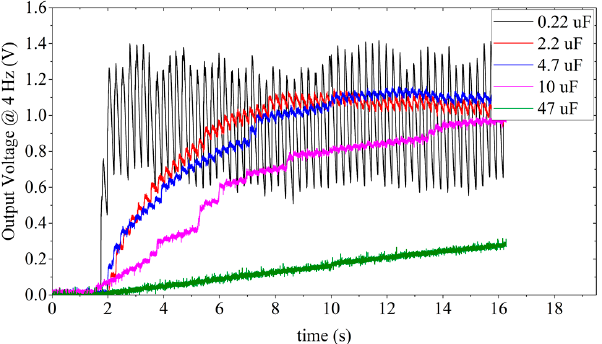
Figure 11. Charging different capacitors (0.22–47 µF) by WearETE under hand clapping movements with 4 Hz frequency. Sensors 2017 , 17 , 2649